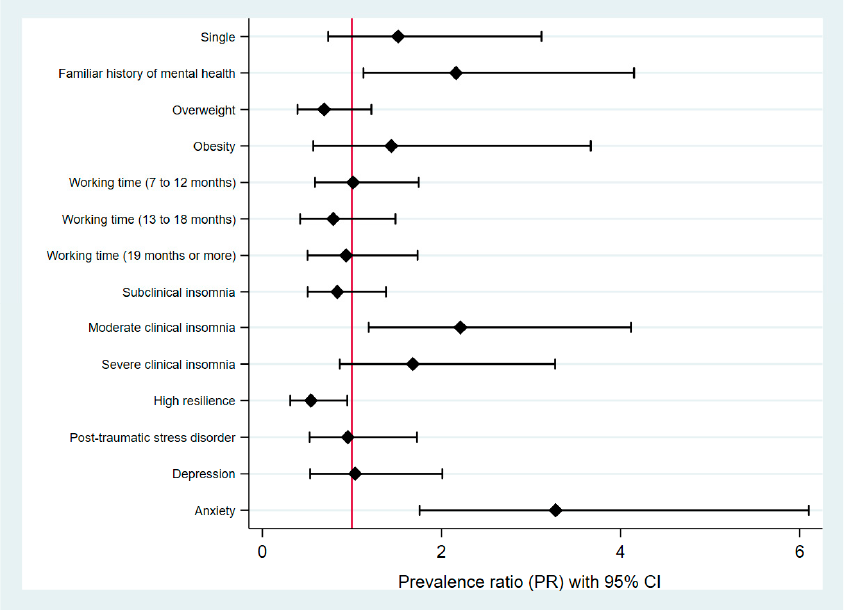
Figure 2. Estimates plot of the factors associated with suicidal risk in multiple regression analysis.